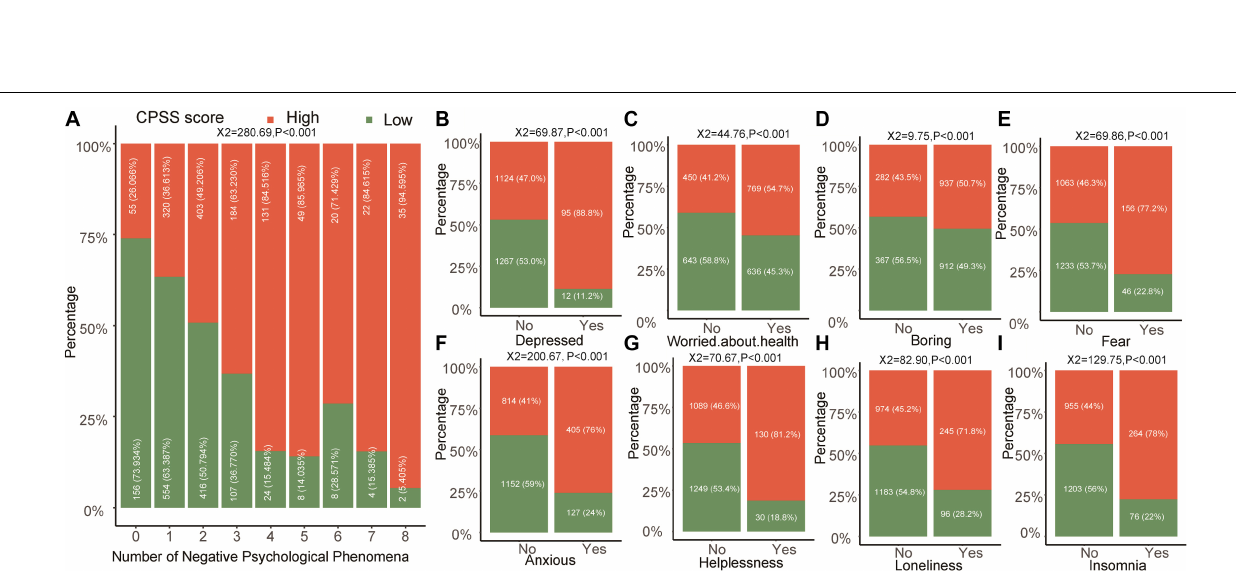
Frontiers in Psychology |